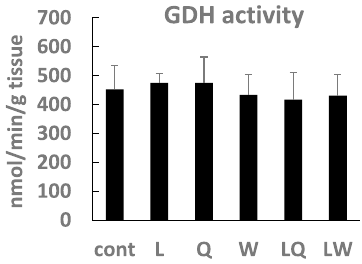
Figure 4. Glutamate dehydrogenase (GDH) activity in the gastrocnemius muscle of mice administered 0.2% xanthan gum solution (Cont), leucine (L), glutamine (Q), tryptophan (W), leucine + glutamine (LQ), or leucine + tryptophan (LW) by gavage after 24 h fasting. Data are expressed as the mean ± SD (n = 5). Mean values without letters are not significantly different among groups (P >